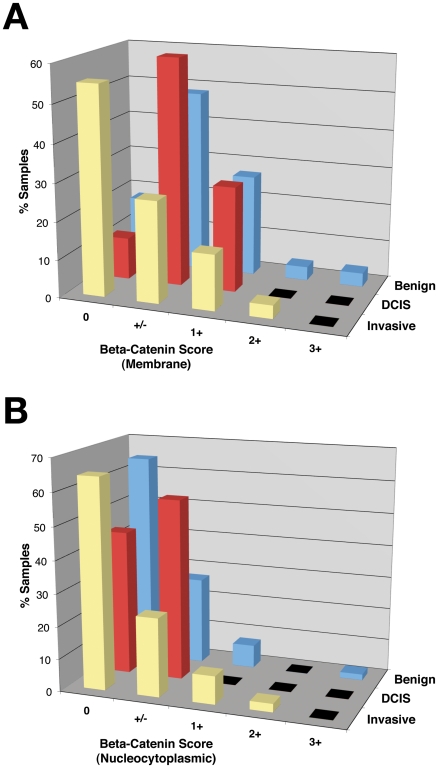
ß-catenin signal as a function of breast cancer progression.Each core was assigned a separate score (0, +/−, 1+, 2+, or 3+) for membrane ß-catenin signal (A) and nucleocytoplasmic ß-catenin signal (B), and the percentage of cores with each score was separately calculated for benign breast tissue, DCIS, and invasive carcinomas. Of note, the staining pattern denoted as +/− in this study appeared visually similar to the staining pattern scored as 1 by Khramtzov and colleagues [27]. A statistically significant reduction in membrane signal was observed in invasive cancers relative to benign breast tissues (P<0.001). A numerical increase in the proportion of DCIS tumors with nucleocytoplasmic ß-catenin compared with normal breast tissue was observed.